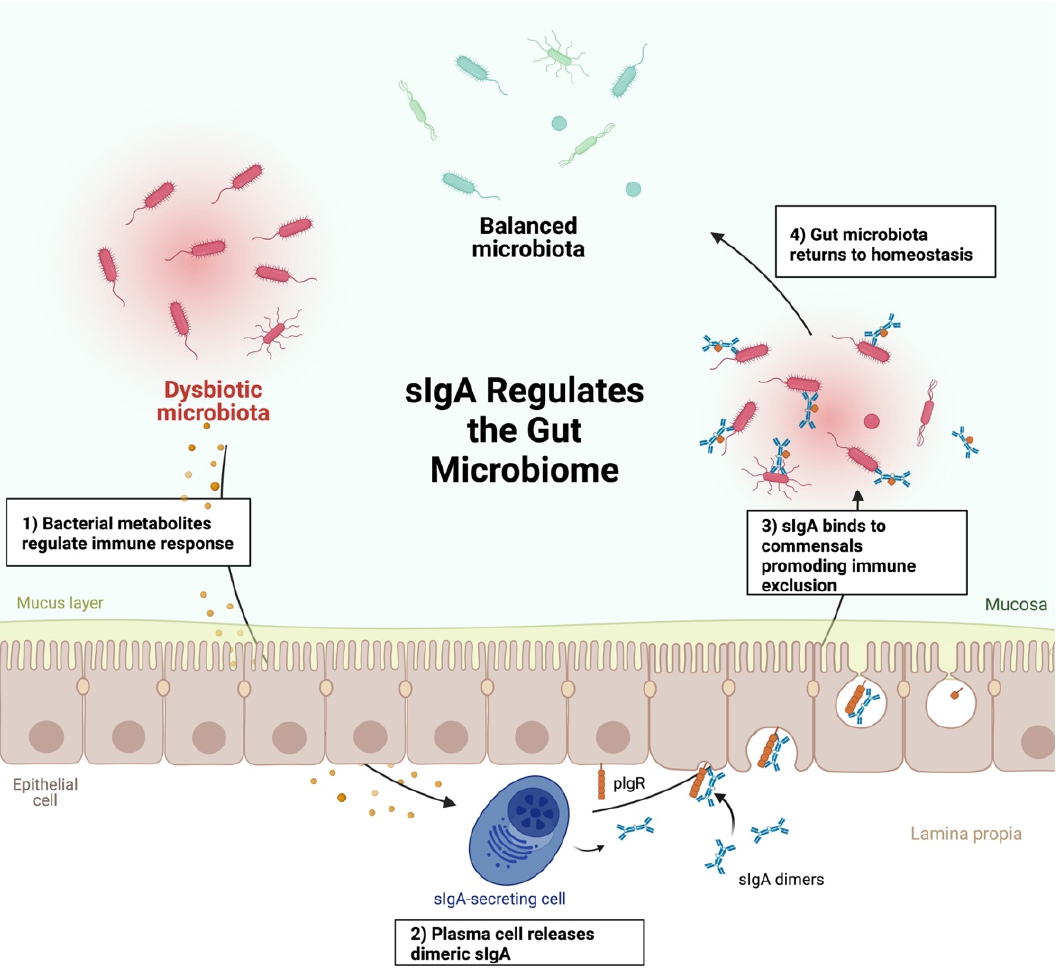
Figure 4. Secretory IgA promotes GI homeostasis through immune exclusion. Dysbioticbacterial metabolites promote cell-mediated immune responses (1). Activation of these responses promotes the production of dimeric IgA by plasma cells (2). Dimeric IgA covalently binds to the polymeric immunoglobin receptor (pIgR) and is transported from the basolateral side of the gut epithelium to the apical side, where it is released by luminal proteases and subsequently binds to commensal bacteria (3), promoting GI homeostasis (4) [105].